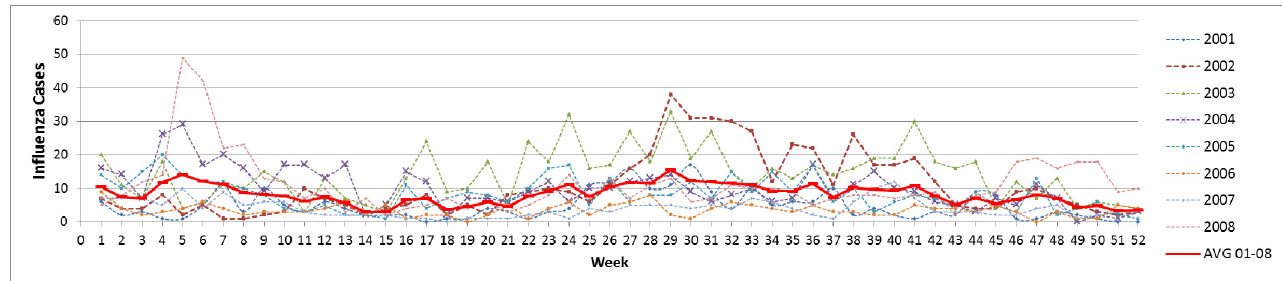
Figure 5. Weekly number of influenza cases during the years 2001–2008.